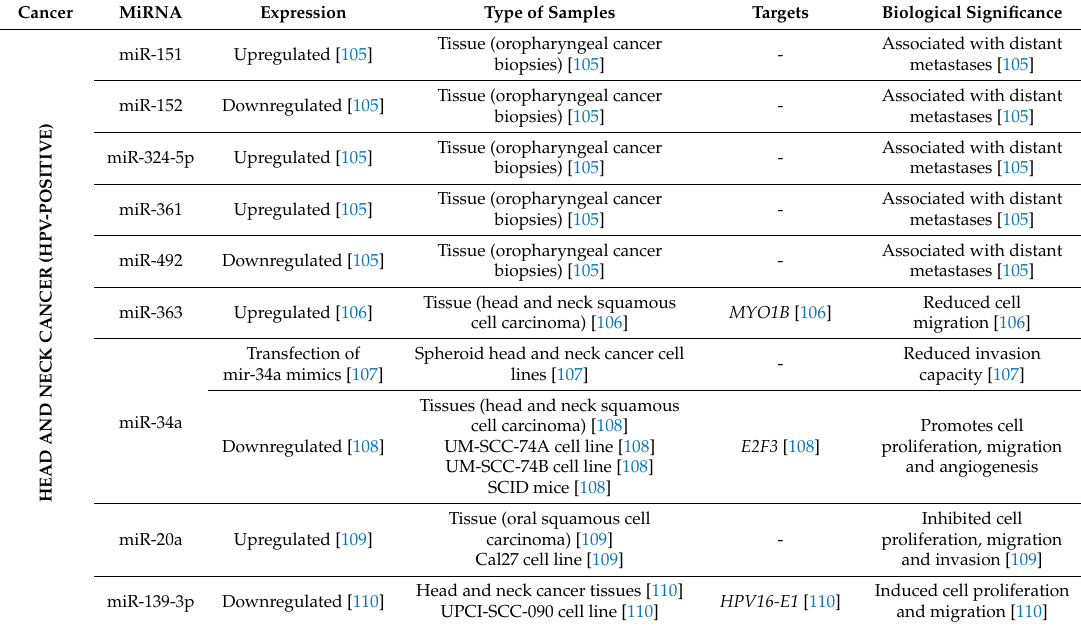
Table 2. MetastamiRs in HPV-positive head and neck